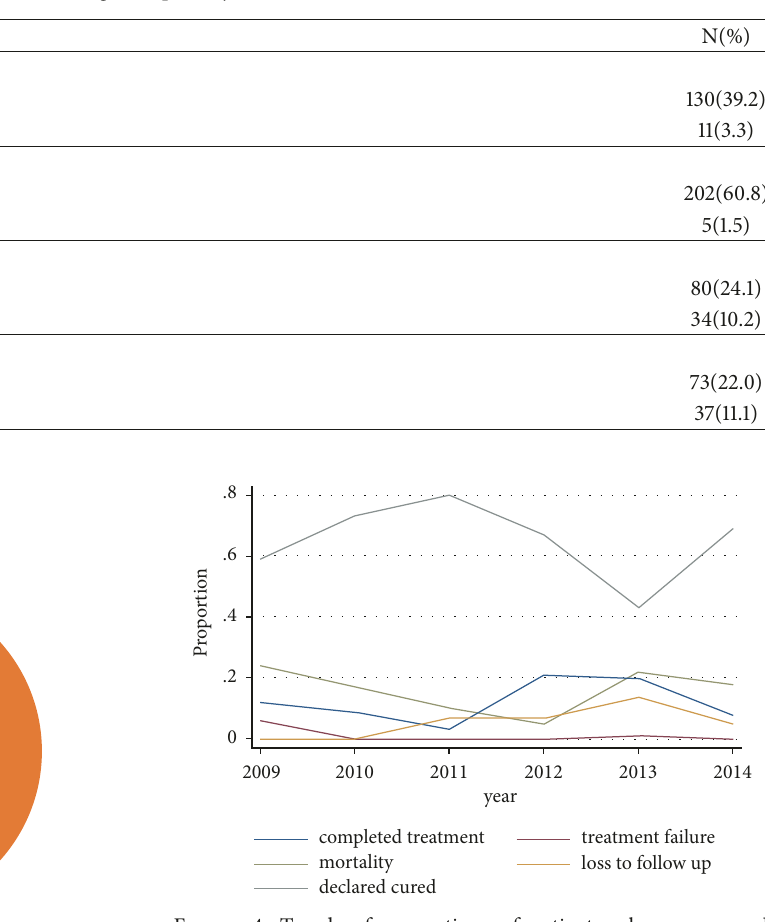
Figure 4: Trends of proportions of patients who were cured, completed treatment, were lost to follow-up, and died from 2009 to